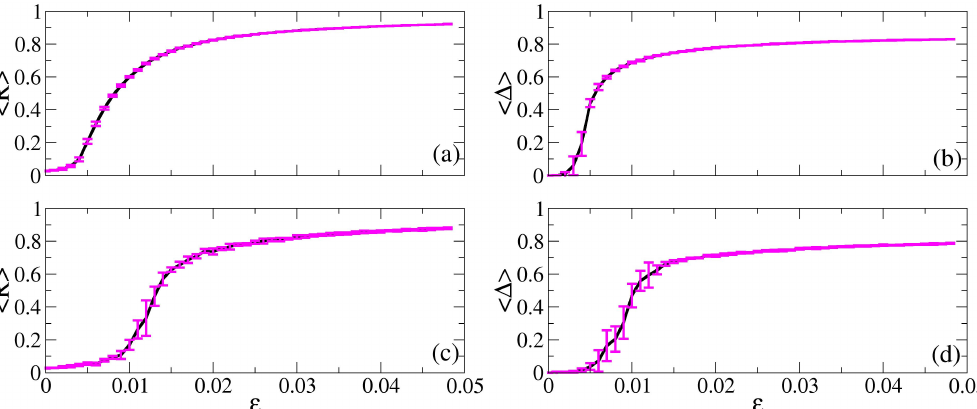
Figure 3. Panels ( a ) and ( c ) depict the mean value of the Kuramoto order parameter ( (cid:104) R (cid:105) ) as a function of the coupling strength ( ε ) for the scale-free and small-world networks, respectively. Panels ( b ) and ( d ) depict the mean value of the determinism ( (cid:104) ∆ (cid:105) ) for the same scale-free and small-world networks. A clear transition to phase synchronized states is observed in both